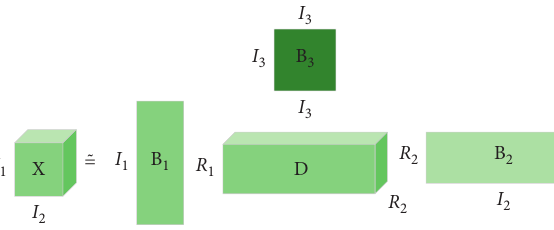
Figure 6: Schematic diagram of Tucker- N decomposition.